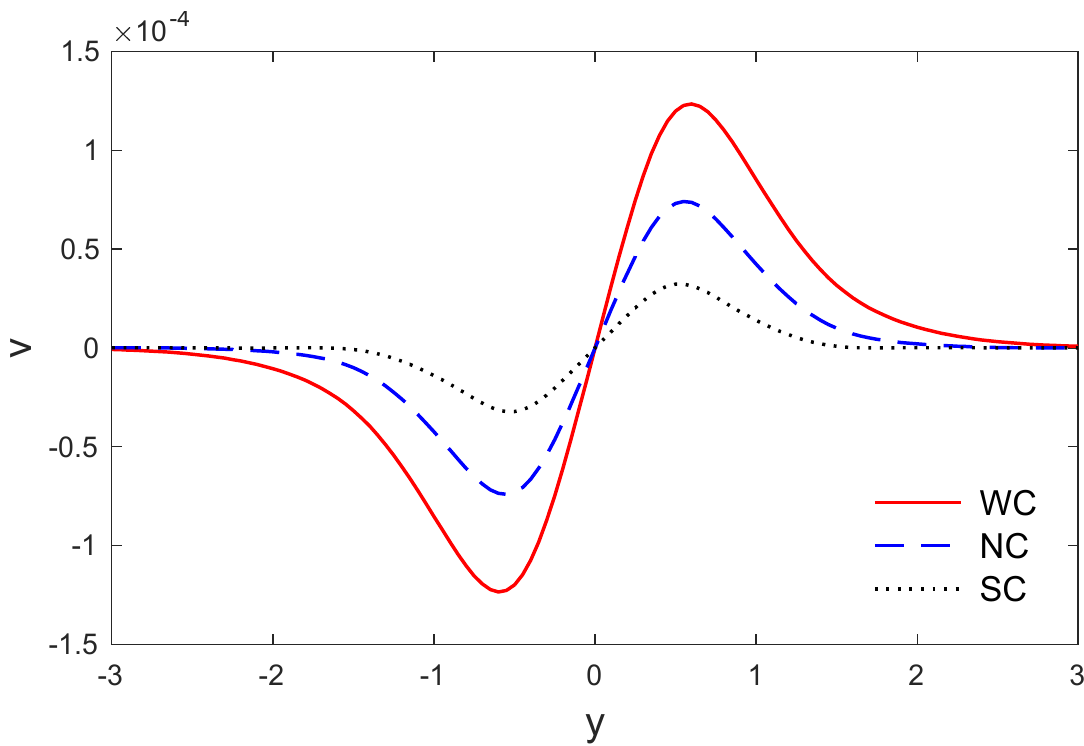
Figure 8. The variations of temperature Θ via (cid:1877) and (cid:1876) = 0.4 for strong normal and weak con- ductivities.